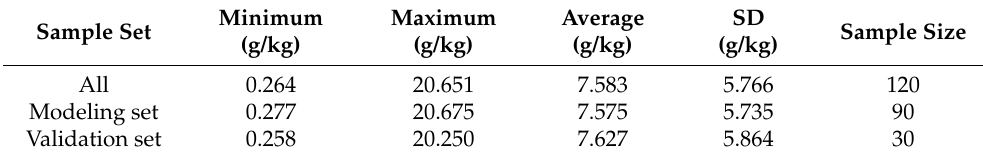
Table 3. Statistics of soil salinity content.